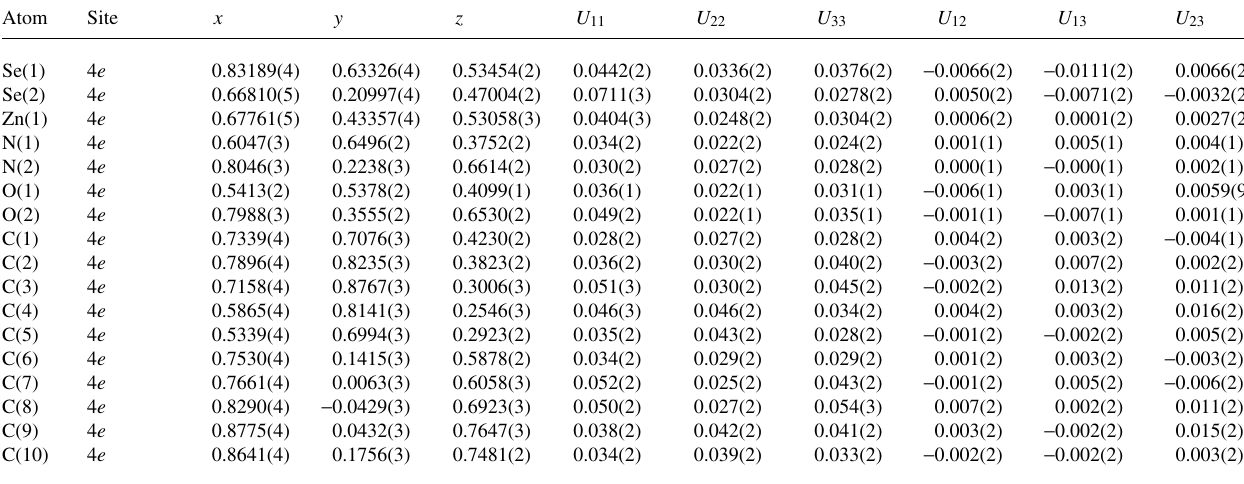
Table 3. Atomic coordinates and displacement parameters (in Å 2 )